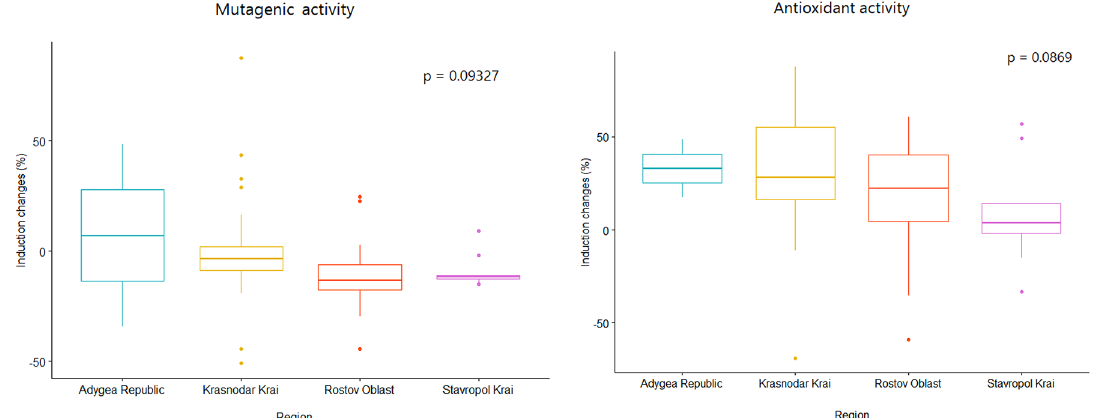
Figure 4. Results of the comparison of median values of mutagenic and antioxidant activity of lactobacilli and spore-forming bacilli isolates from bats of different regions by the Kruskal–Wallace